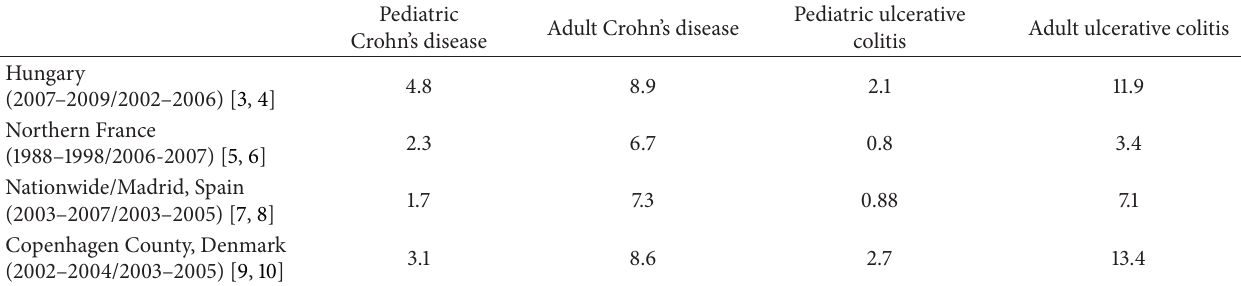
Table 1: Incidence rates of pediatric- and adult-onset Crohn’s disease and ulcerative colitis in different countries (/100,000).